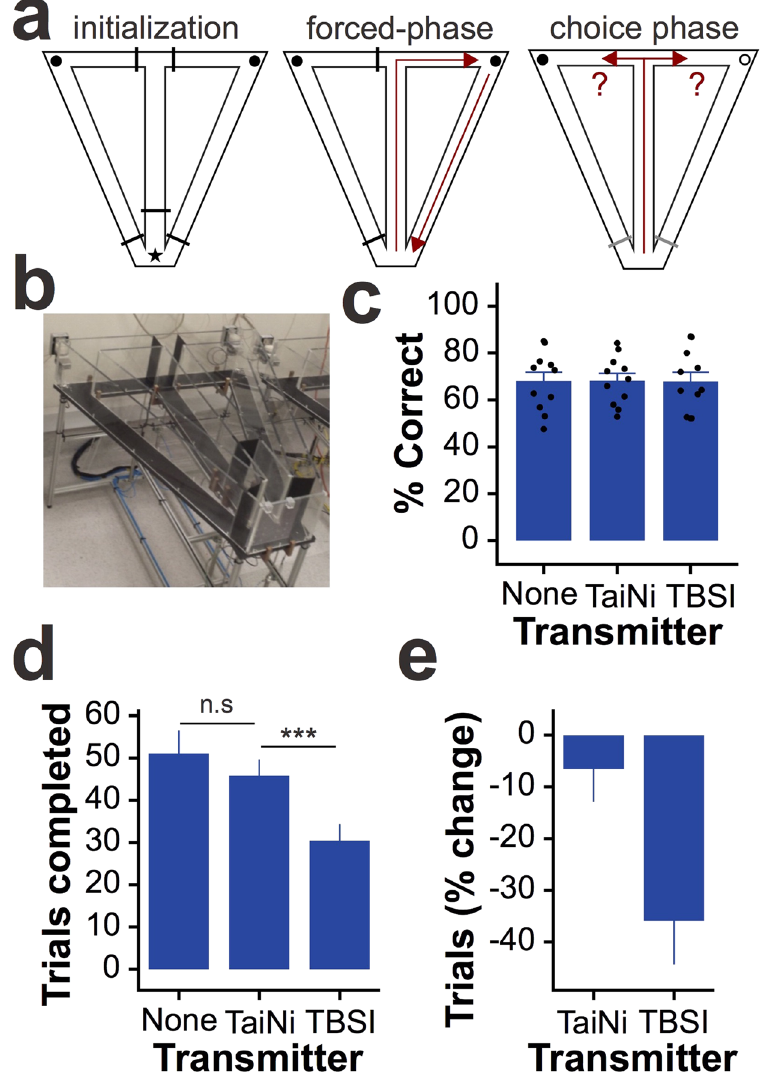
Figure 3. Behavioural impact of the TaiNi transmitter. The TaiNi transmitter. ( a ) The design of the automated T-maze task. Left: all doors (black bars) are raised and the mouse is confined to the waiting-zone (star). Both reward locations (circles) are baited with food. Middle: only one door is opened, forcing the mouse to retrieve one of the rewards and return to the waiting-zone. Right: both doors at the choice-point are opened and the mouse must remember which of the two rewards still remains. ( b ) A photo of one of the mazes. ( c ) The percentage of correct choices under each transmitter condition (NONE = no transmitter). Each mouse was run under all three conditions on three separate days. Dots show the data-points from each mouse. ( d ) The number of trials completed under each condition. ( e ) The percentage change in the number of trials completed, per- mouse, when wearing either the TaiNi or the TBSI transmitter, compared with the NONE condition. The TBSI transmitter induced a 35.9% reduction in trials completed. Error bars show SEM. *** p <